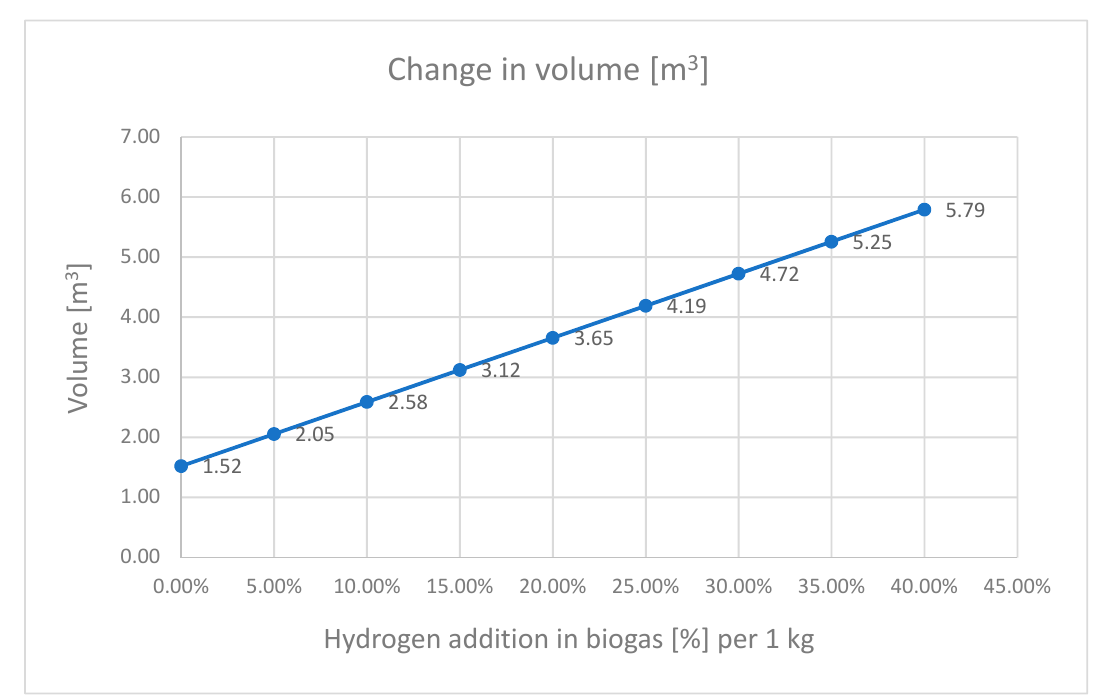
Figure 9. Change in gas volume as a function of hydrogen mass content .